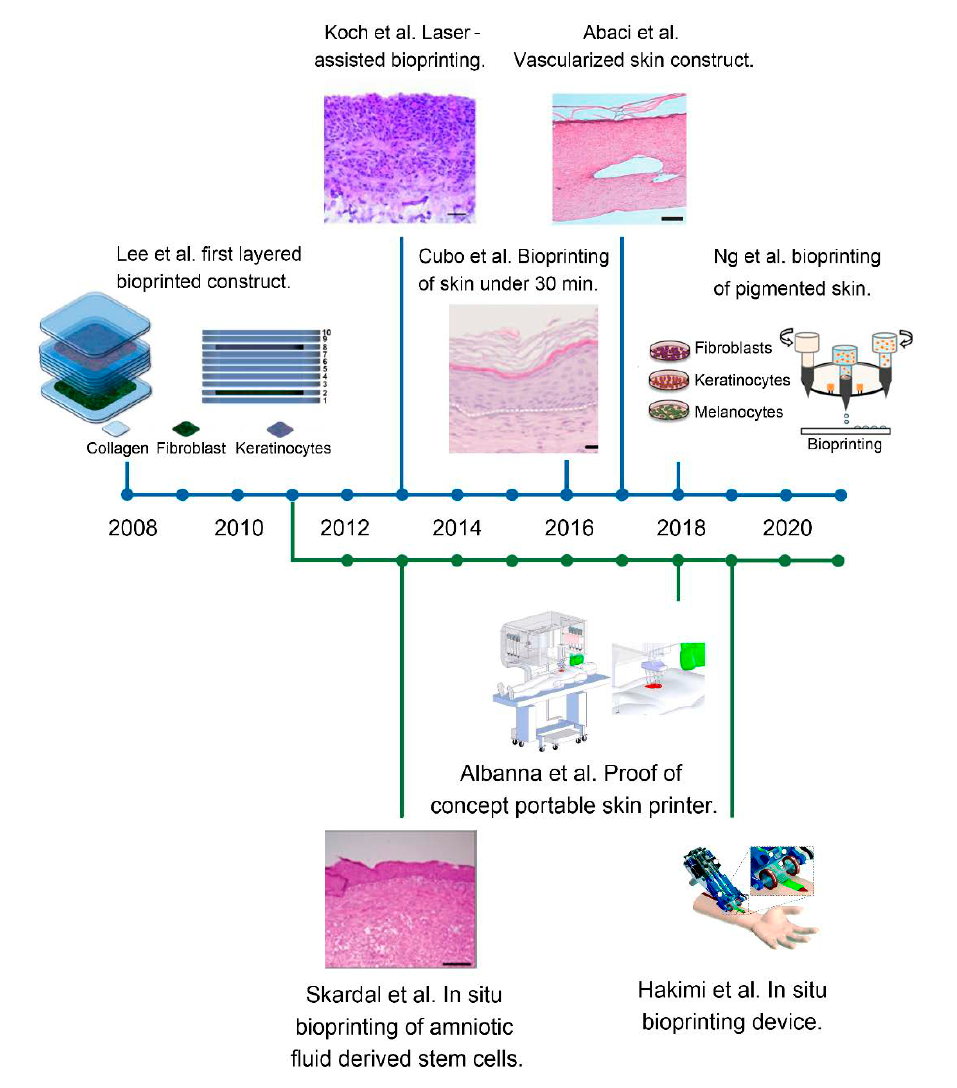
Figure 8. Timeline depicting the different advances and trends in bioprinted skin. The top blue line represents the in vitro approach, whilst the bottom parallel green line represents the in situ strategy. The evolution of bioprinted skin constructs is reflected, from the first simplified bilayered structures containing only two cell types, to the most recent work and notable achievements, such as the vascularisation, the inclusion of different cell types and the development of portable bioprint- ers. Reproduced with permission from Lee et al., Koch et al., Cubo et al., Abaci et al., Ng et al., Skardal et al., Albanna et al. and Hakimi et al. [81–83,111,125,129,131,132]. Copyrights2012, 2016 John Wiley & Sons; 2016, 2018 IOPscience; 2009 Elsevier; 2018 Royal Soci-ety of Chemistry;